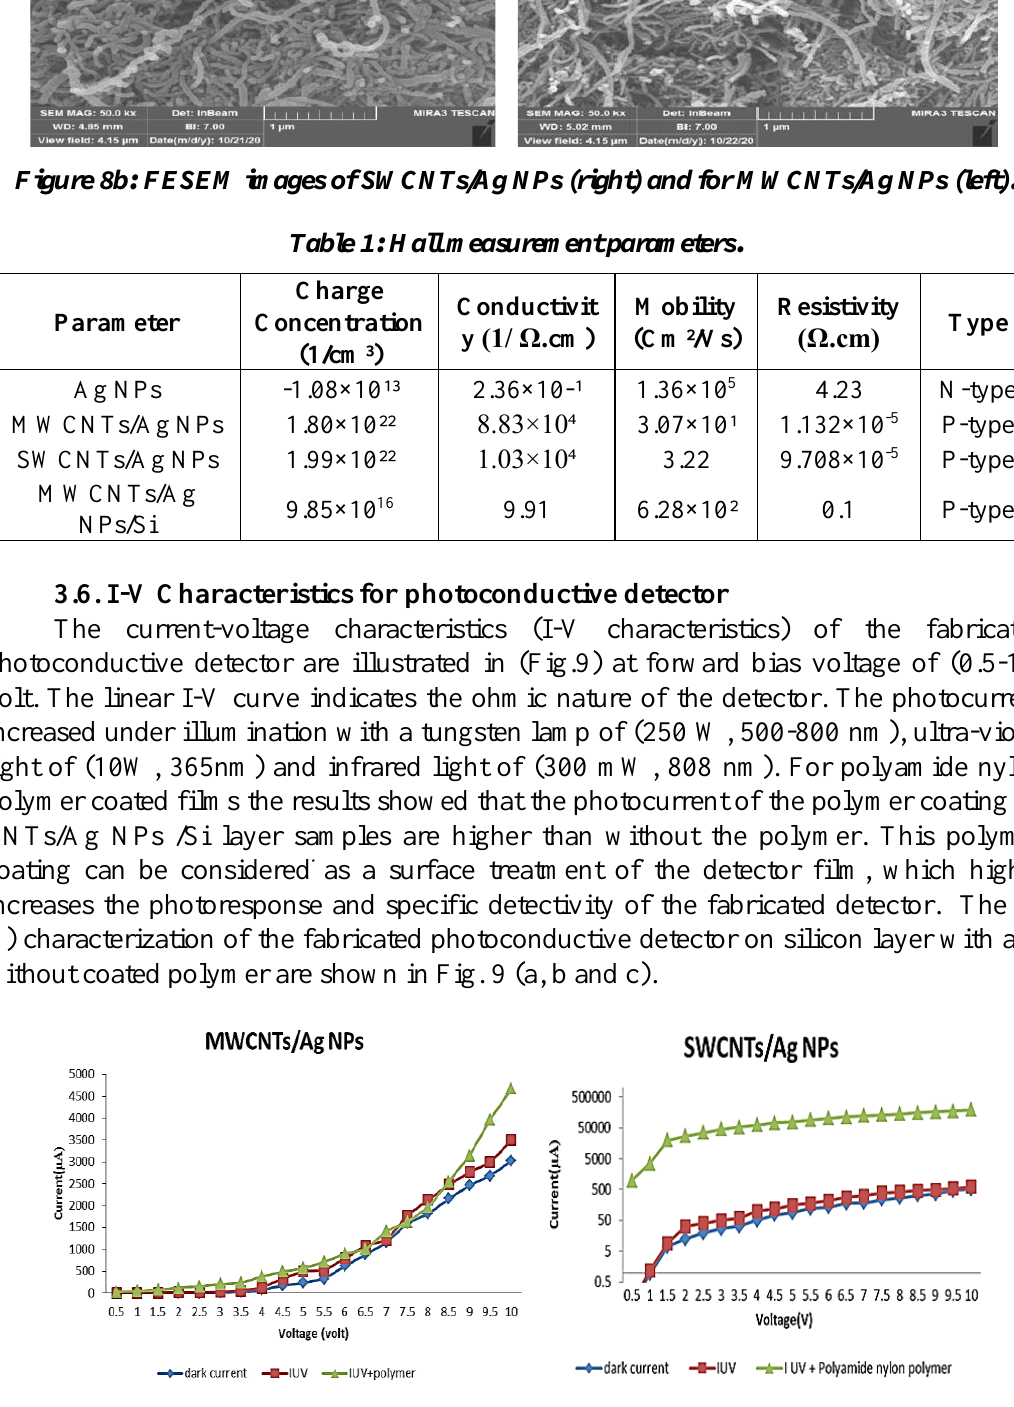
Figure 9a: The variation ofֹ the UV photo-current of the fabricated photoconductive detector with coating polymer for SWCNTs/Ag NPs and MWCNTs/Ag